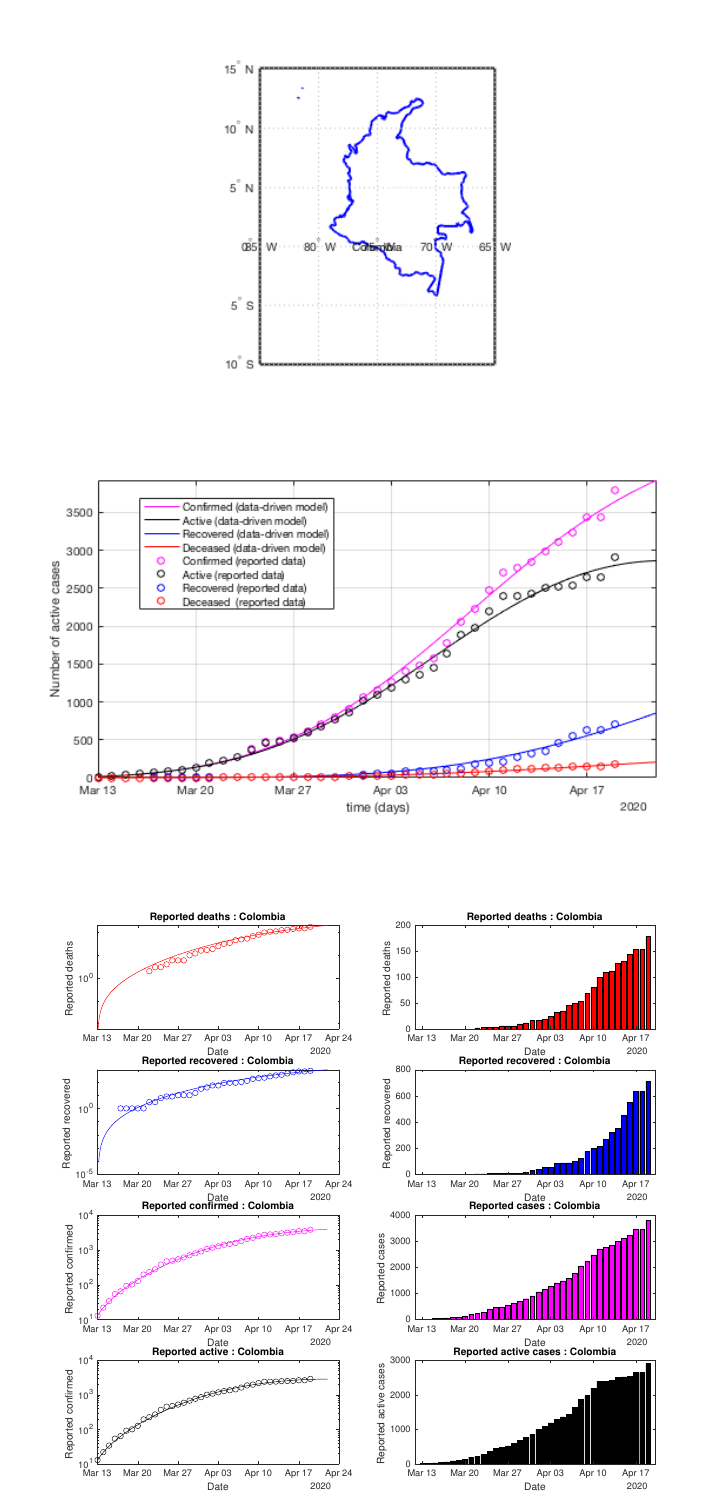
Figure 24. Colombia: data of active, recovered, deceased (in circle or bar) vs. model of active, recovered, deceased over time. Tracking the number of active cases. Predictive analytics for the next couple